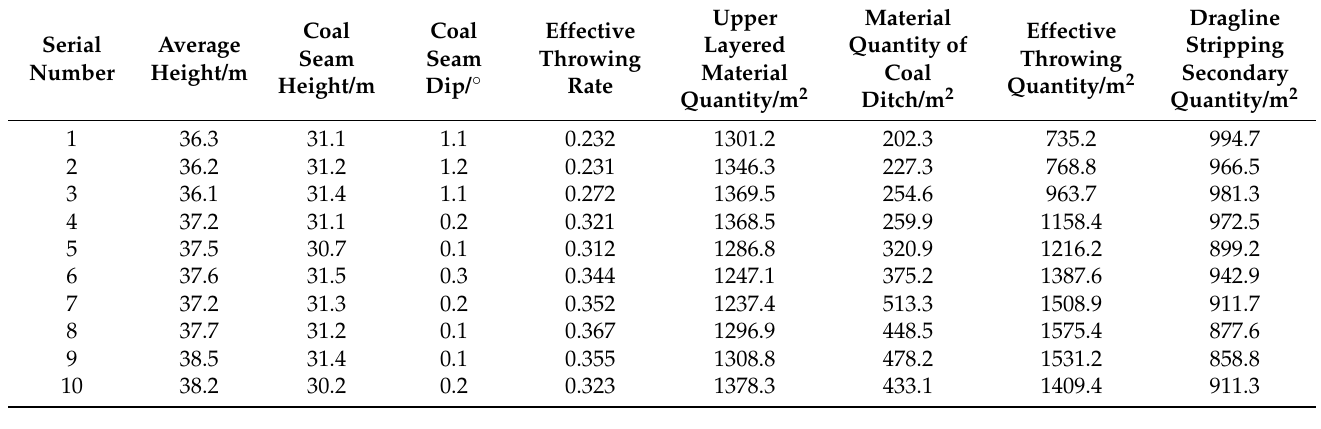
Table 3. Partial database of critical operation index of cast blasting stockpile.